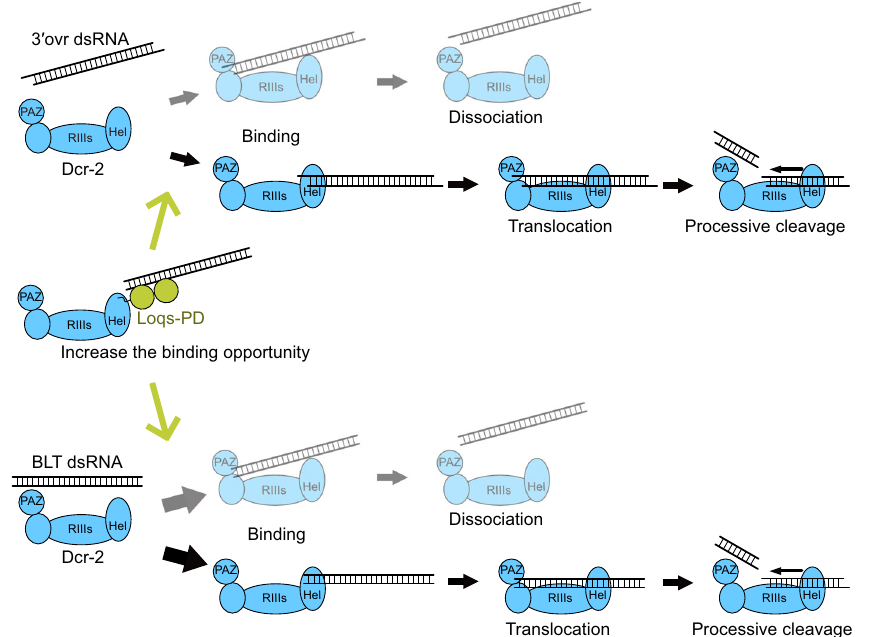
Fig. 4 A model for modulation of Dcr-2 ’ s cleavage activity by the dsRNA terminal structures and Loqs-PD. BLT dsRNAs have a higher chance to be cleaved than 3 ′ ovr dsRNAs. A common mechanism of processive cleavage is used for both BLT and 3 ′ ovr dsRNAs. Loqs-PD simply increases the binding opportunity for both BLT and 3 ′ ovr